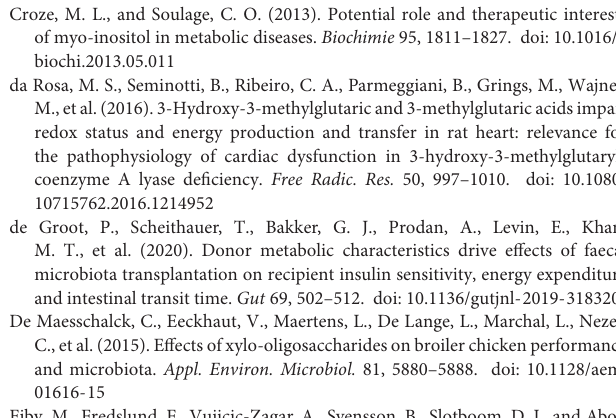
Supplementary Figure 1 | LEfSe (Linear discriminant analysis effect size) analysis of functional pathways of broiler cecum between XOS and control groups (A) ; between BBC and control groups (B) ; between MIX and control groups (C)